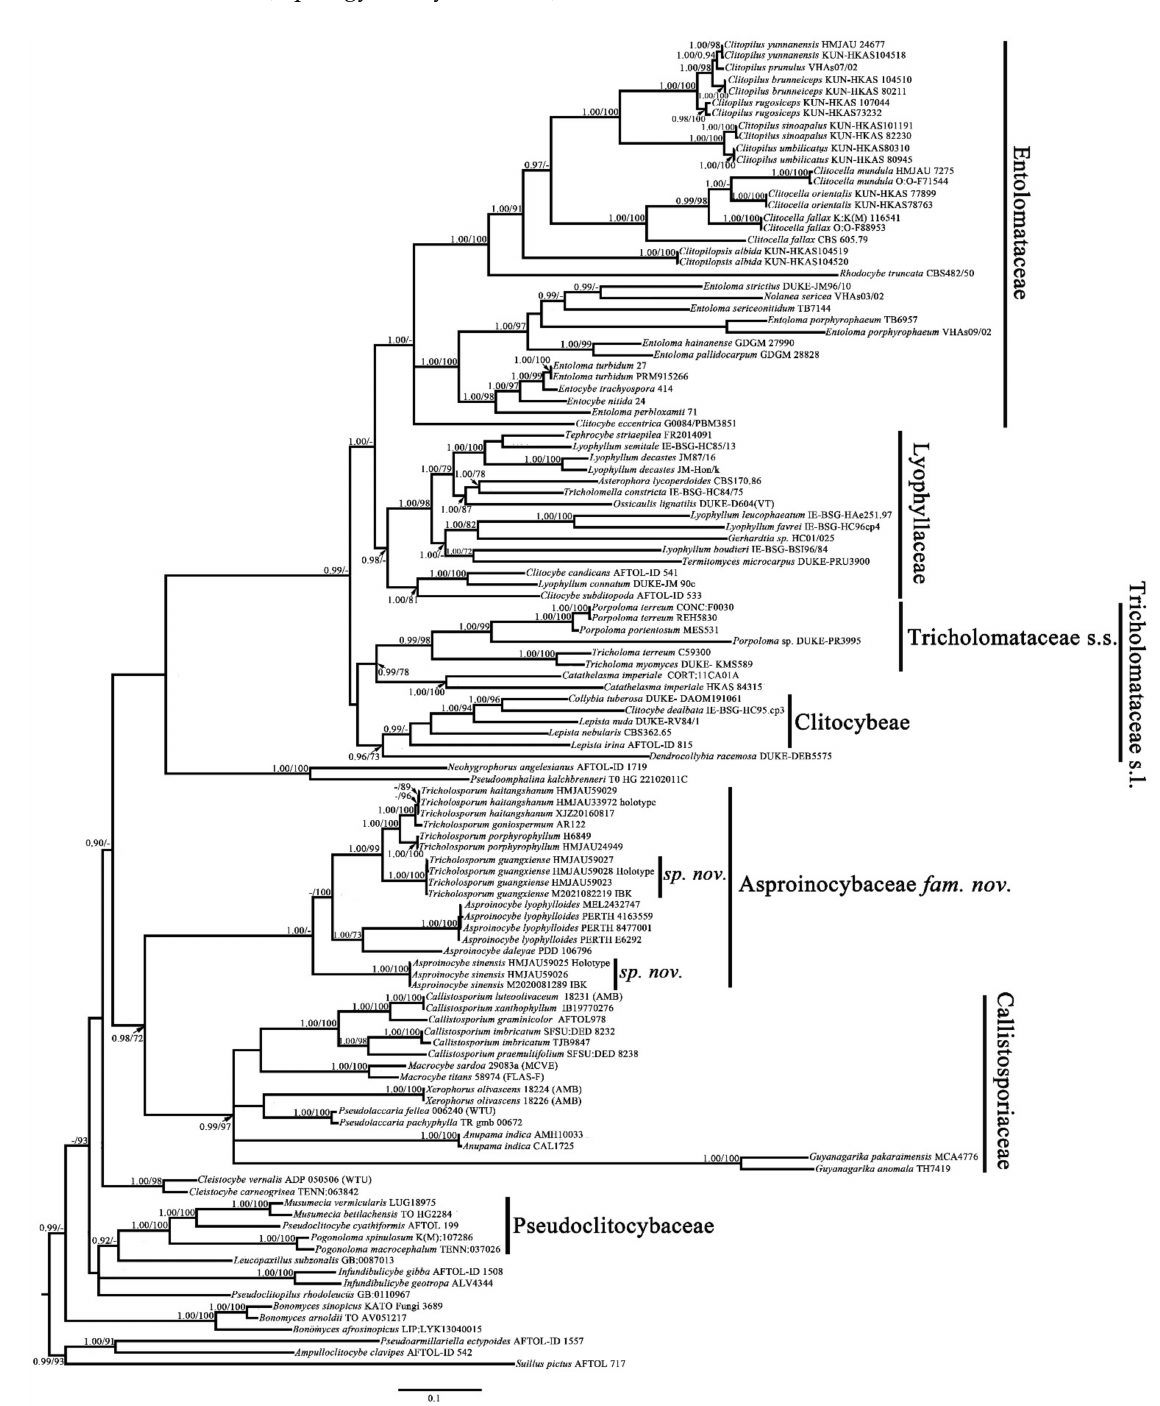
Figure 1. Phylogenetic tree inferred from partial ITS + nrLSU + RPB1 + RPB2 + nrSSU + TEF1- α sequences, showing phylogenetic relationships of Asproinocybaceae and related taxa (with Suillus pictus , Pseudoarmillariella ectypoides , and Ampulloclitocybe clavipes as outgroups). Bayesian inference (BPP ≥ 0.90) and maximum likelihood support values (ML ≥ 70) are shown